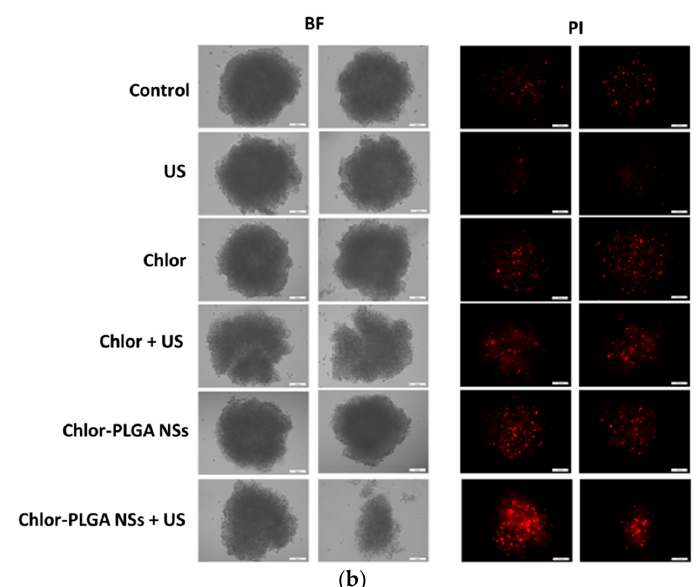
Figure 11. Optical (bright field, BF) and fluorescence (propidium iodide, PI) micrographs of DU-145 spheroids. DU-145 spheroids were left untreated or exposed to Chlor or Chlor-PLGA NSs and their respective combinations with US. Spheroids were stained with PI 24 h following treatment. Panel ( a ) shows PI quantification expressed as % of PI fluorescence intensity/µm 2 . Statistically significant vs. no US exposure: * p < 0.05. Panel ( b ) shows representative pictures of spheroids, taken 24 h after each treatment, in bright field (BF) or stained with PI in fluorescence field. Magnification: 10×. Scale bars: 100 µm.